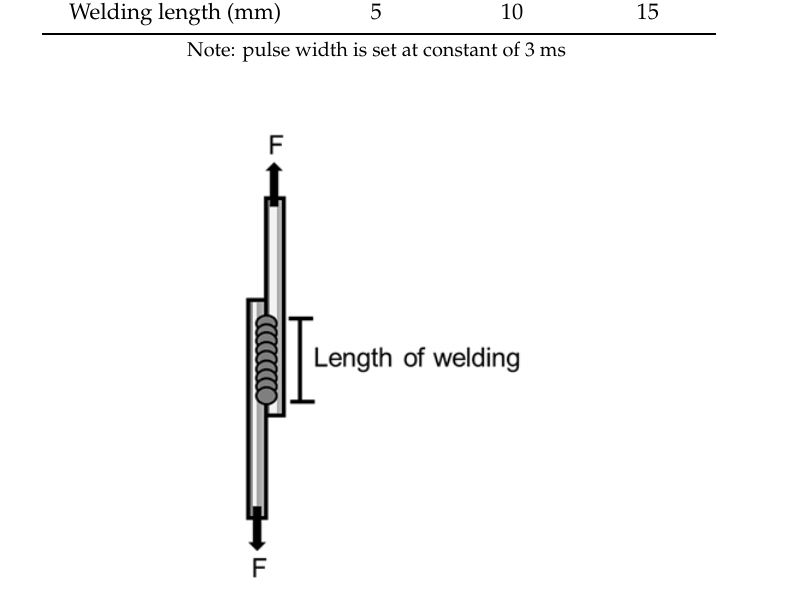
Figure 7. Schematic view of the relationship between shear loading and weld joint. Table 2. Variables for testing the tensile strength.